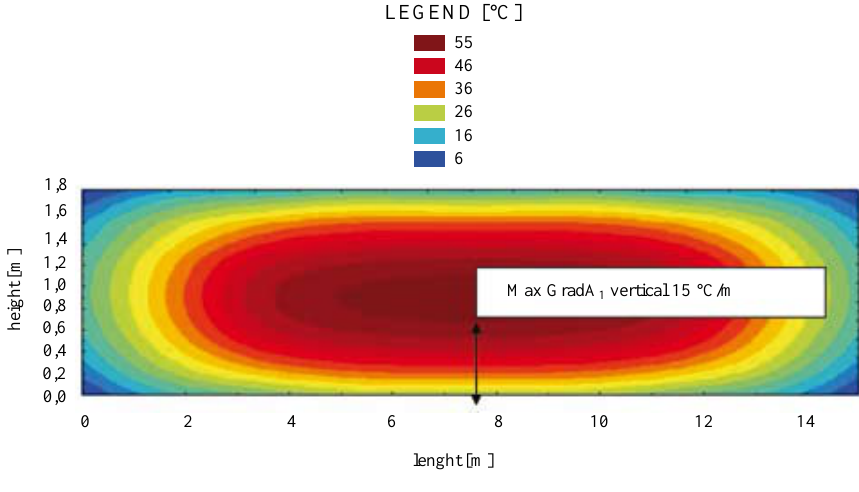
Fig. 4. Temperature distribution in the concrete block /vertical